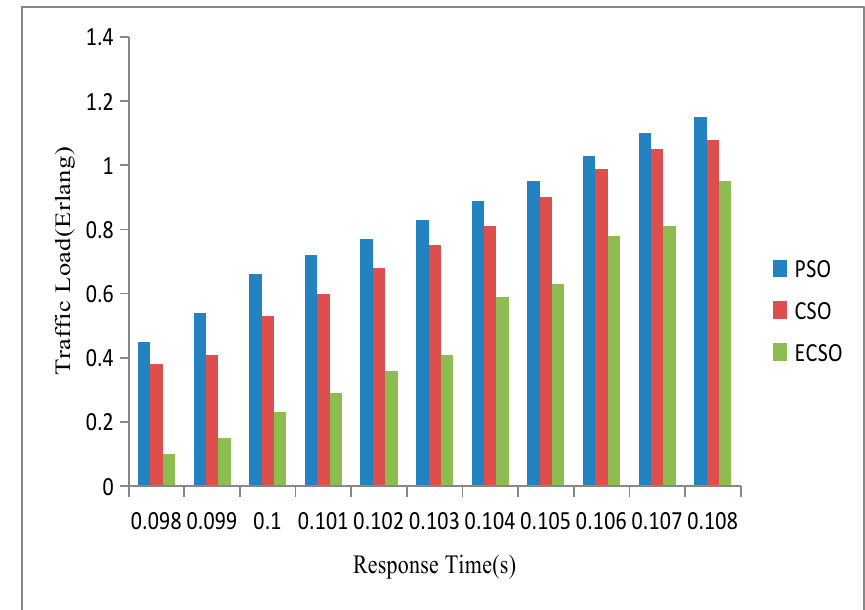
Figure 8. Comparative analysis of response time against existing methods.